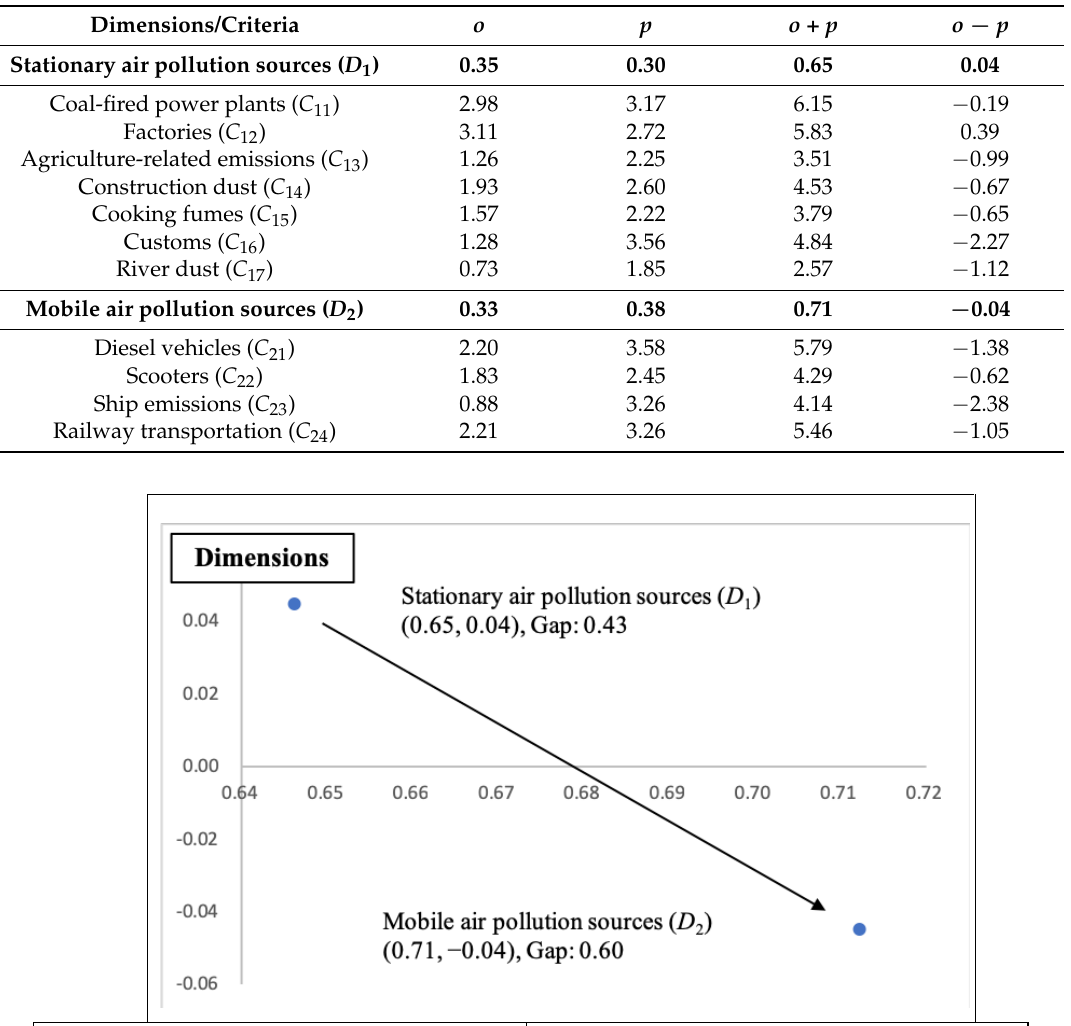
Table 3. Performance evaluation of the empirical case using modified Vlse Kriterijuska Optimizacija Komoromisno Resenje (VIKOR). Dimensions/Criteria